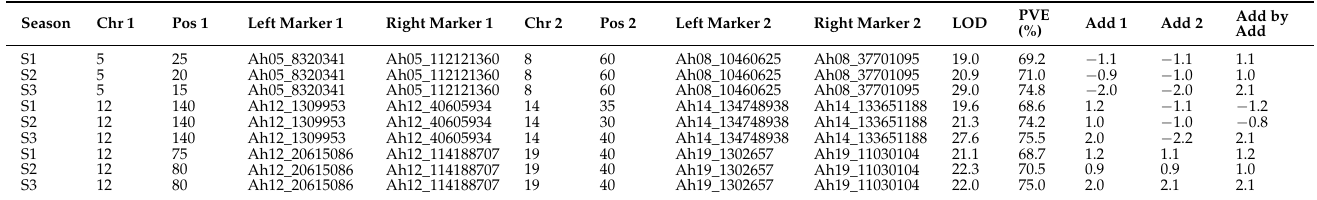
Table 3. Epistatic QTLs (Q × Q) consistently identified in S1, S2, and S3 for